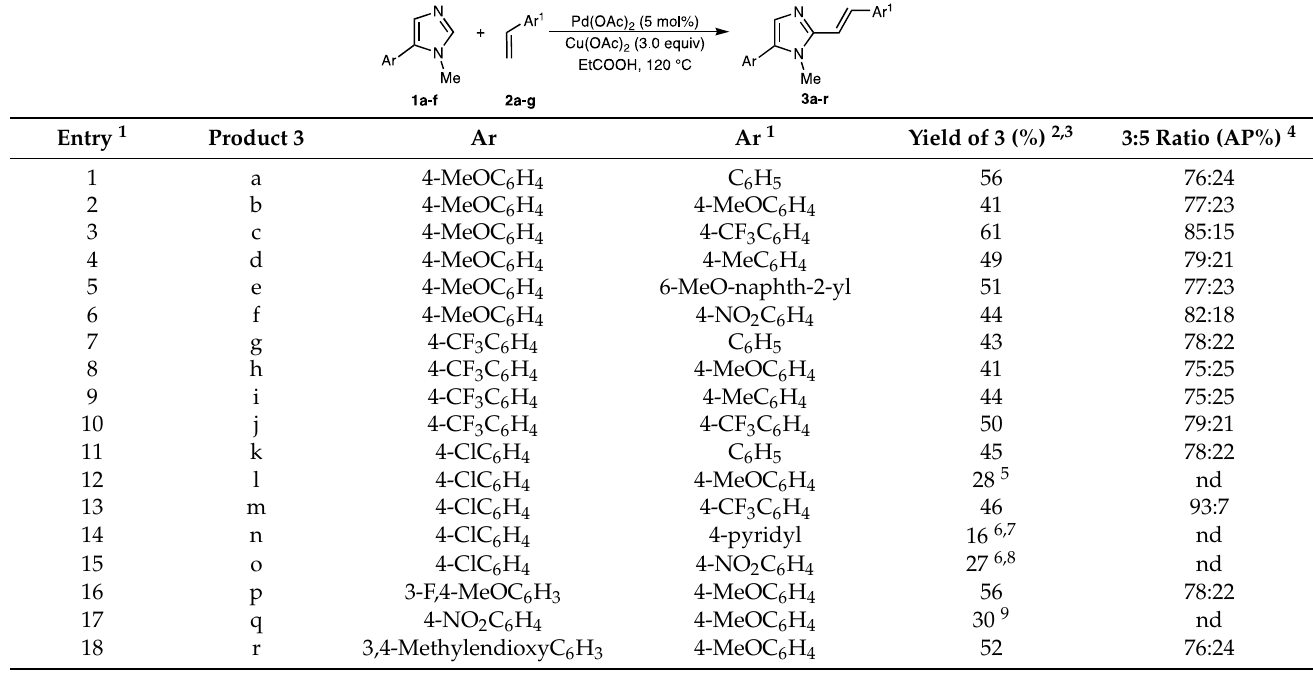
Figure 1. Chemical structures of imidazole derivatives 1a – f , 6 , 7 , 10 , 12 , 14 , and of styrenes 2a – g . Table 2. Pd-catalyzed, Cu(II)-promoted synthesis of 2-alkenyl-5-aryl-1-methylimidazoles 3a – r by intermolecular dehydrogenative alkenylation of imidazoles 1a – f with styrenes 2a – g .